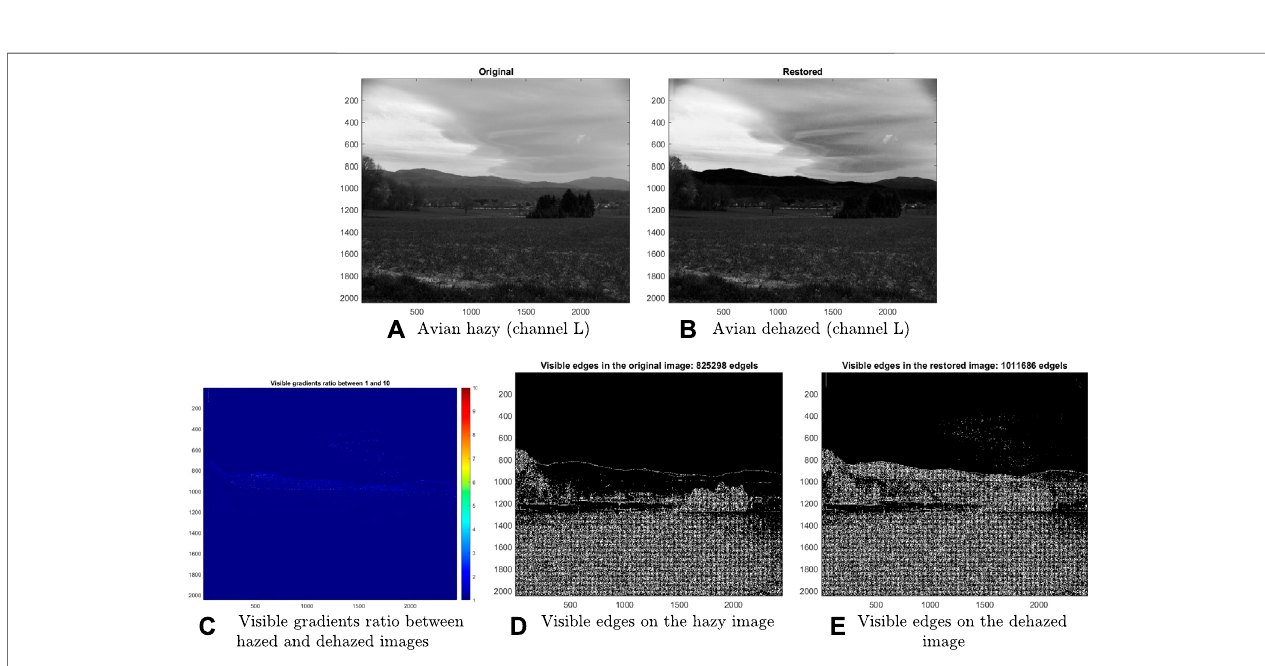
FIGURE 7 | Visualizations of the output from the Hautière et al. (2011) metrics, applied on the sensor band L of the avian sensitivity.